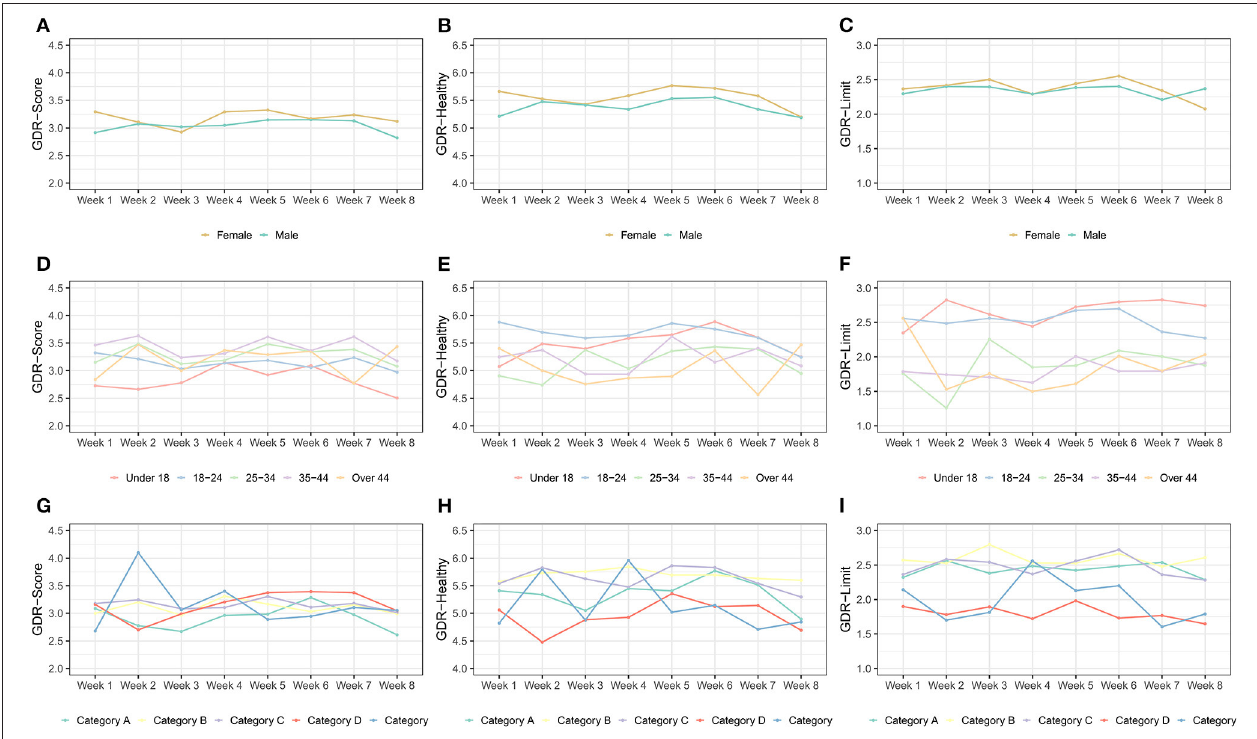
FIGURE 5 | Temporal patterns of diet quality across sex, age, and economic groups. (A) GDR Score across sexes. (B) GDR-Healthy Score across sexes. (C) GDR-Limit Score across sexes. (D) GDR Score across age groups. (E) GDR-Healthy Score across age groups. (F) GDR-Limit Score across age groups. (G) GDR